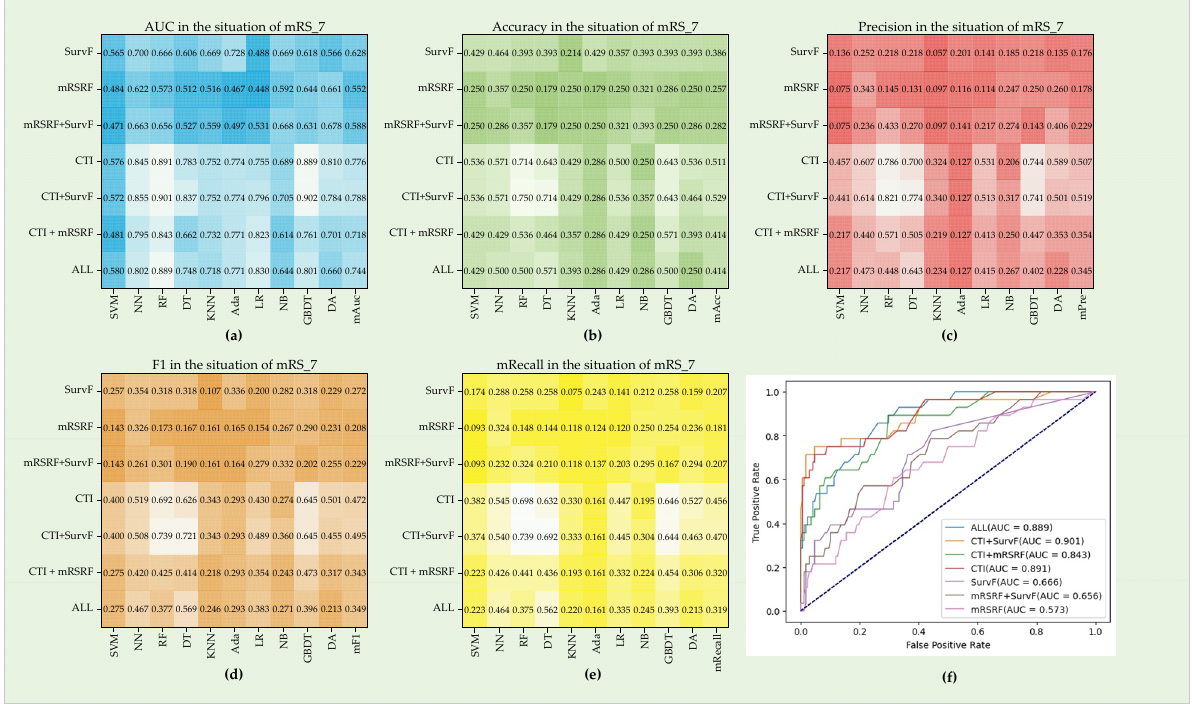
Figure 9. Performance of seven feature groups in the situation of mRS_7. ( a – e ) Auc, Pre, Acc, F1, and Recall on the ten models. ( f ) ROC curves of seven feature groups on the RF model.